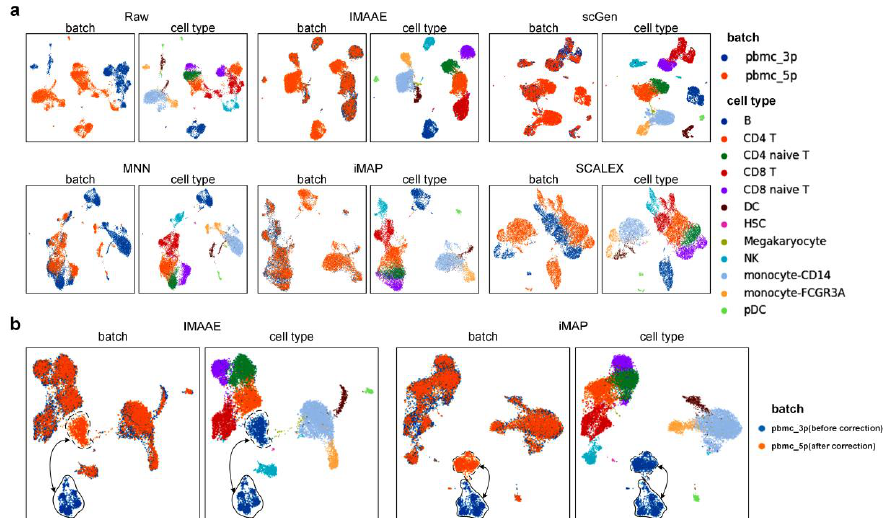
Figure 6. ( a ) Qualitative evaluation of each batch correction method using UMAP visualization on PBMC-subset2 dataset. ( b ) Mismapping phenomenon of PBMC-subset3 dataset before and after correction. Each method contains two UMAP plots. On the left, coloring by batch type, and on the right, coloring by cell type.